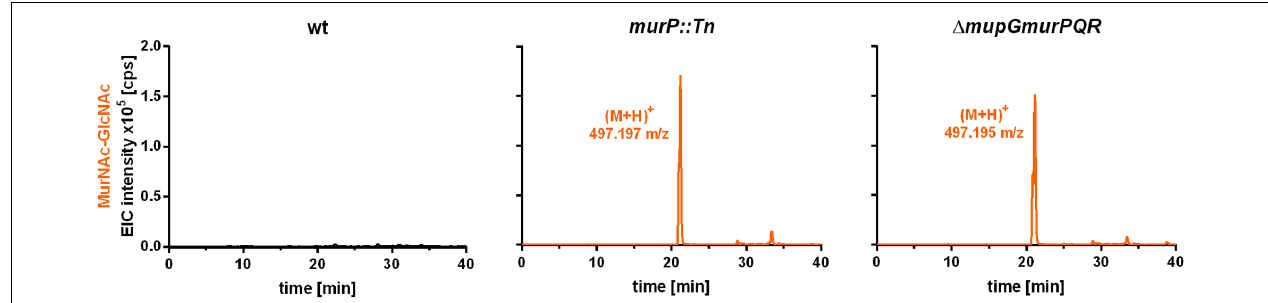
FIGURE 6 | LC-MS analysis from recycling mutants, lacking MurP transporter. S. aureus wild type (wt) cells, a murP transporter mutant ( murP::Tn ) and a murQ -operon mutant ( (cid:49) mupGmurQPR ) were grown to stationary phase (24 h) in LB. Bacterial cultures were centrifuged and 1 ml of each supernatant was transferred to 500 µ l of ice-cold acetone to remove macromolecules and proteins from the samples. After centrifugation, culture supernatants were dryed in the speedvac, solved in 50 µ l of Millipore water and 2 µ l of the samples were injected to the HPLC column. MS analysis of the culture supernatants was performed in positive-ion mode and mass spectra are presented as extracted ion chromatograms (EIC × 10 5 counts per second [cps]) in orange. In the culture supernatants of both mutants, an additional compound accumulates ( murP::Tn , observed mass of (M+H) + = 497.197 m/z; (cid:49) mupGmurQPR , observed mass of (M+H) + = 497.195 m/z). The mass of this compound in the supernatant corresponds to a disaccharide made of GlcNAc and MurNAc. This compound was further analyzed by MS fragmentation and identified as MurNAc-GlcNAc (see Supplementary Figure 5 ). MS data are shown as representative from three biological